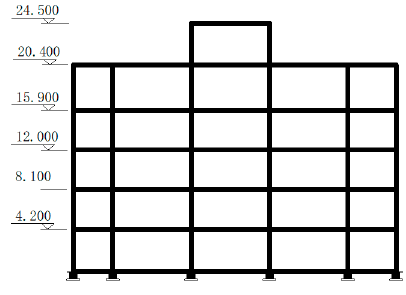
Figure 8. Side elevation of building (m).